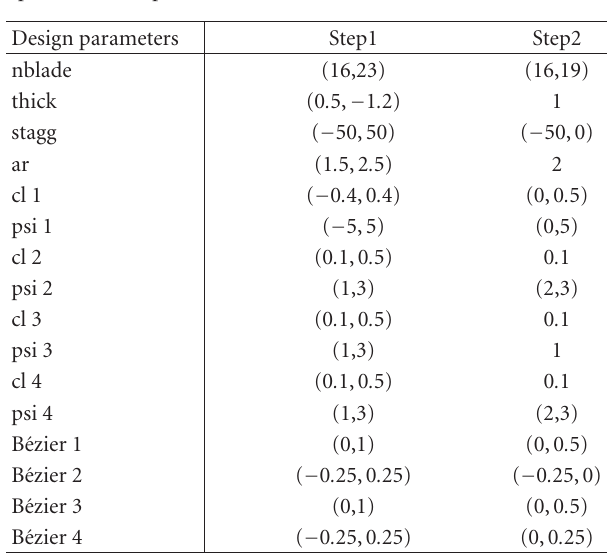
Table 4: Comparison of the variable ranges of the first and second optimization